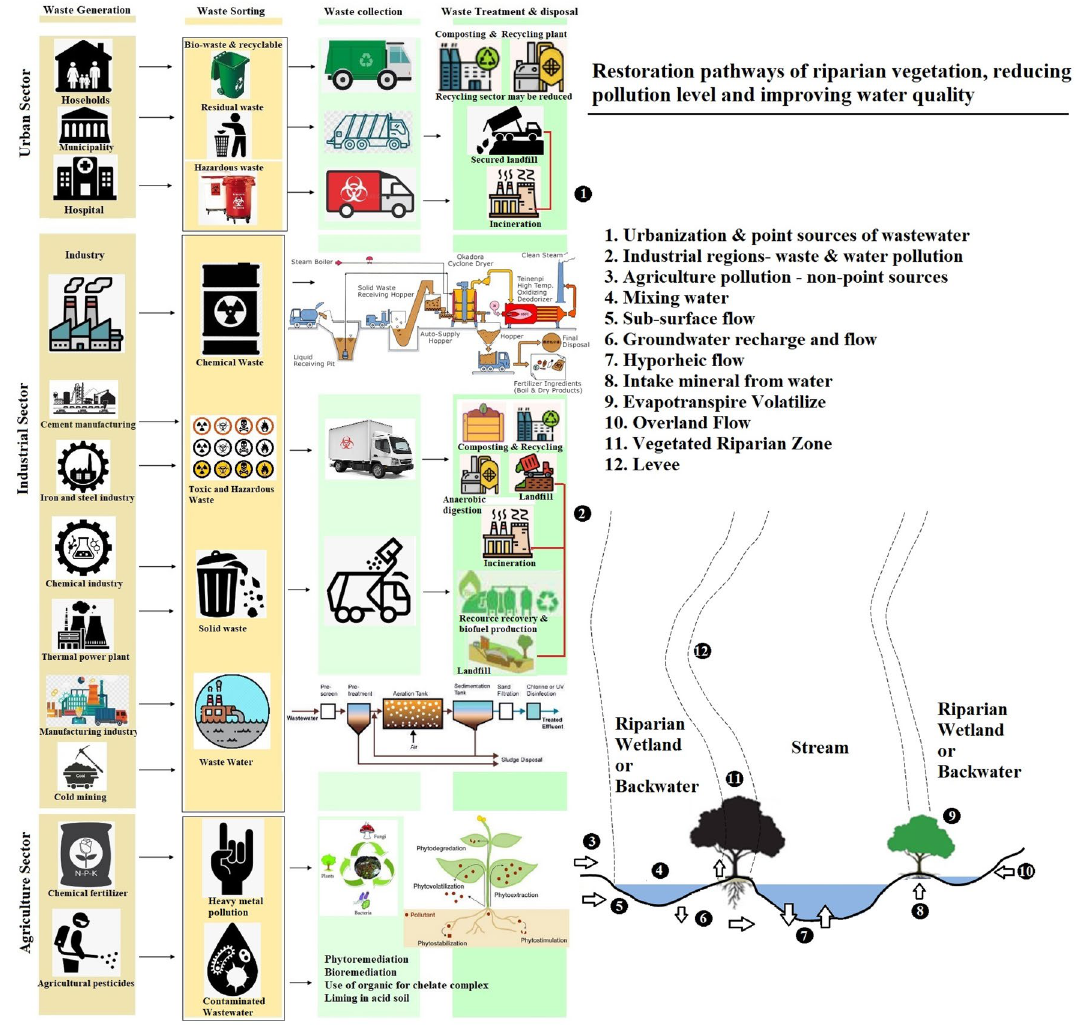
Figure 5. Eco-restoration and management plan for reducing pollution and improving river water quality (RWQ). This figure is prepared by MS office 2007 (https:// micro soft- office- 2007. en. softo nic.